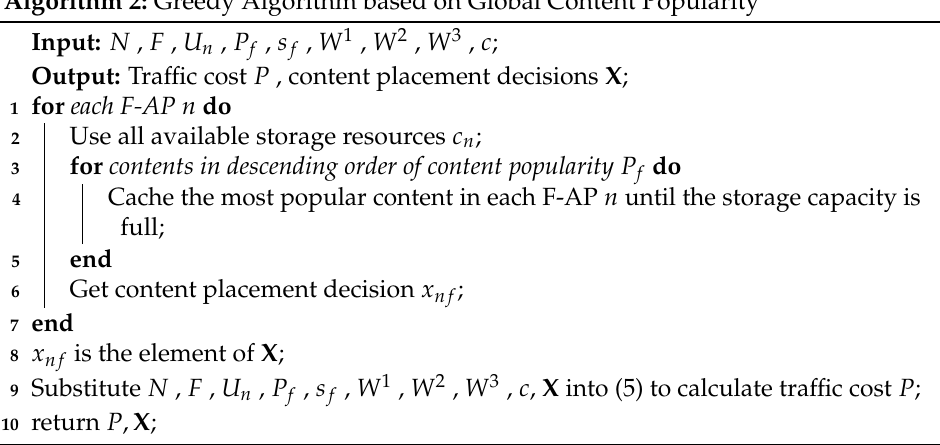
Algorithm 2: Greedy Algorithm based on Global Content